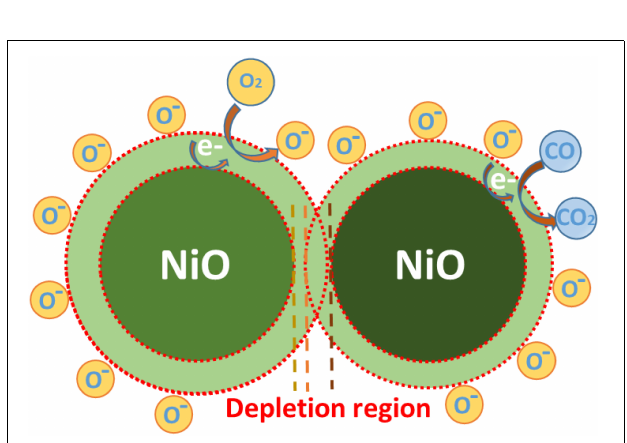
FIGURE 10 | The schematic diagram of sensing mechanism.